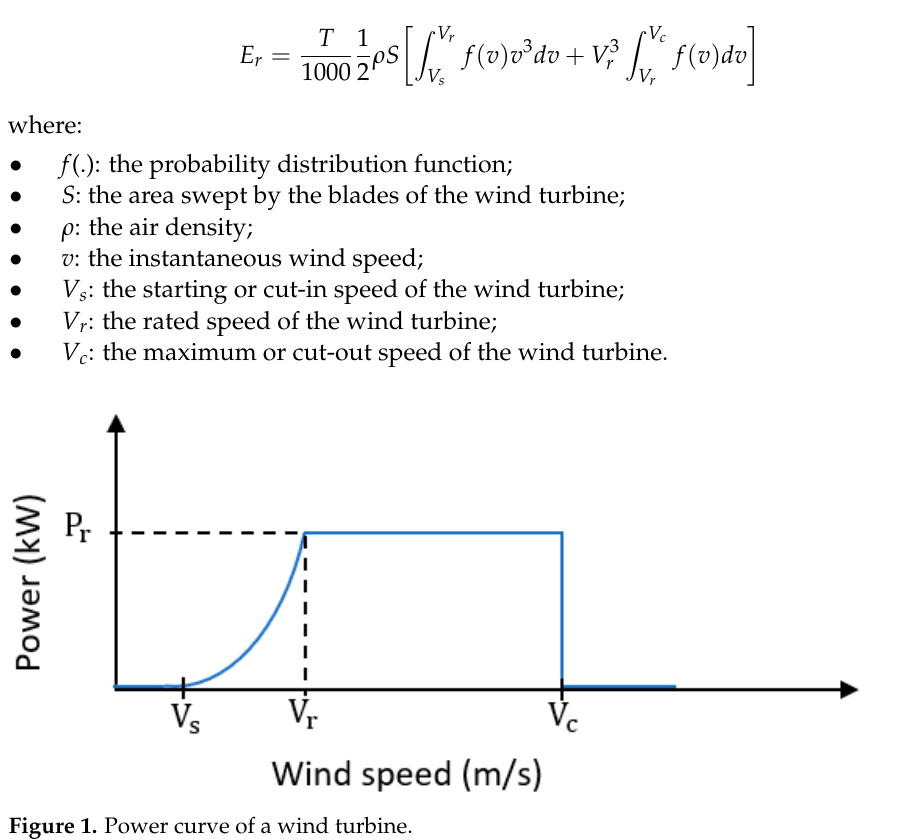
Figure 1. Power curve of a wind turbine.